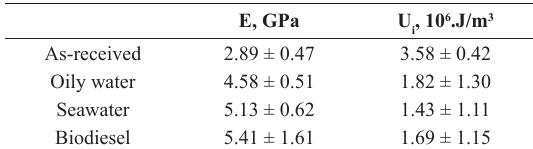
Table 1. Flexural modulus (E), and the energy consumed to initiate the macroscopic failure